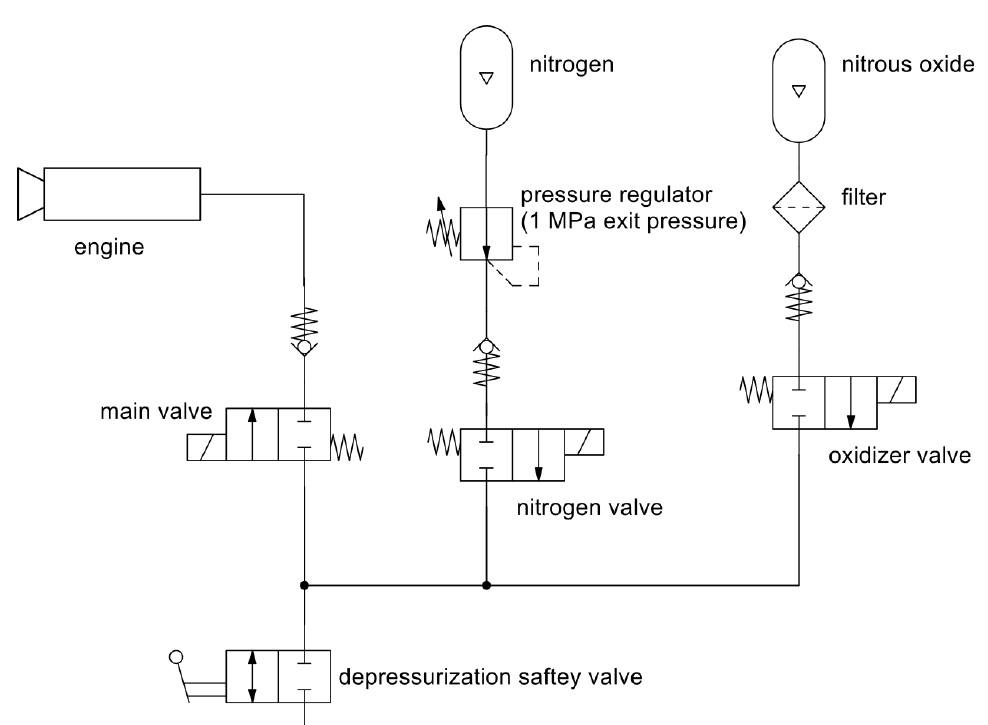
Figure 11. The fluid system of the engine test bed with the separated nitrogen and nitrous oxide feeding